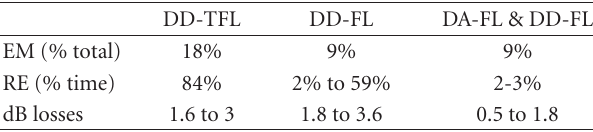
Table 4: Features of the three